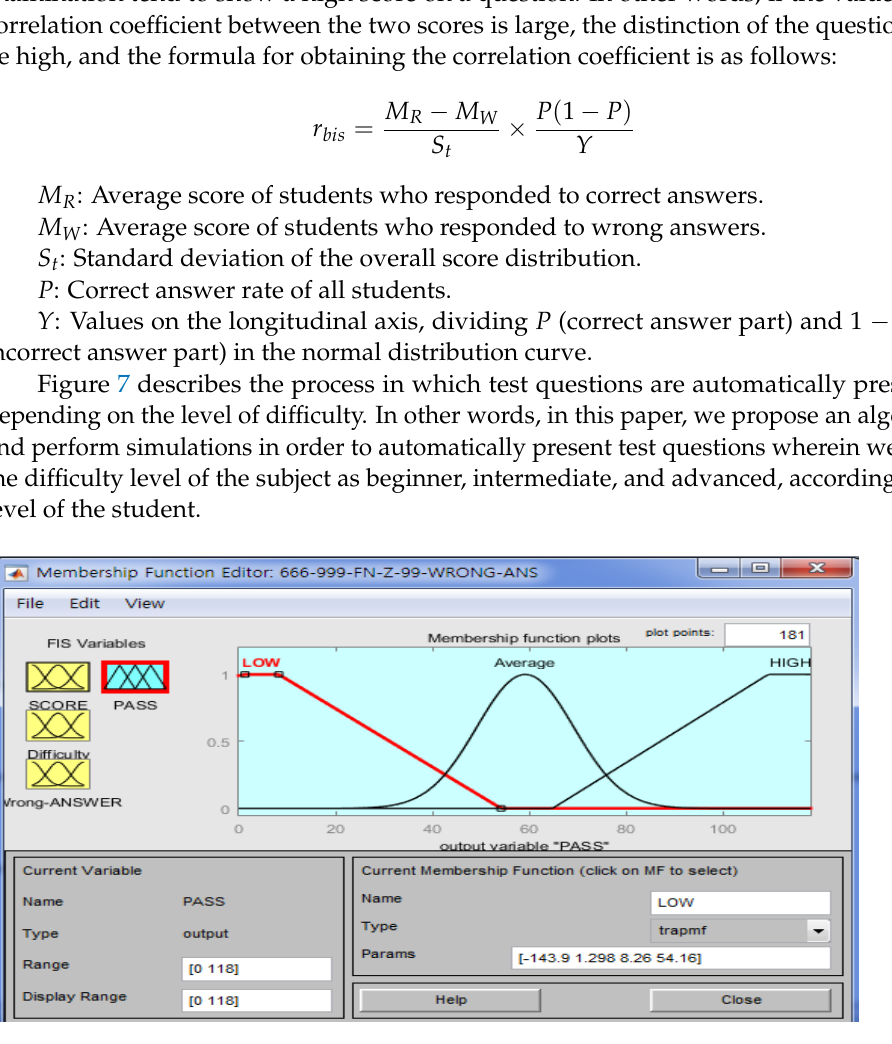
Figure 8. Computer simulation result. IF SCOR E = Medium Level and Wrong answer rate = High Level and Absent = Low Level and Then